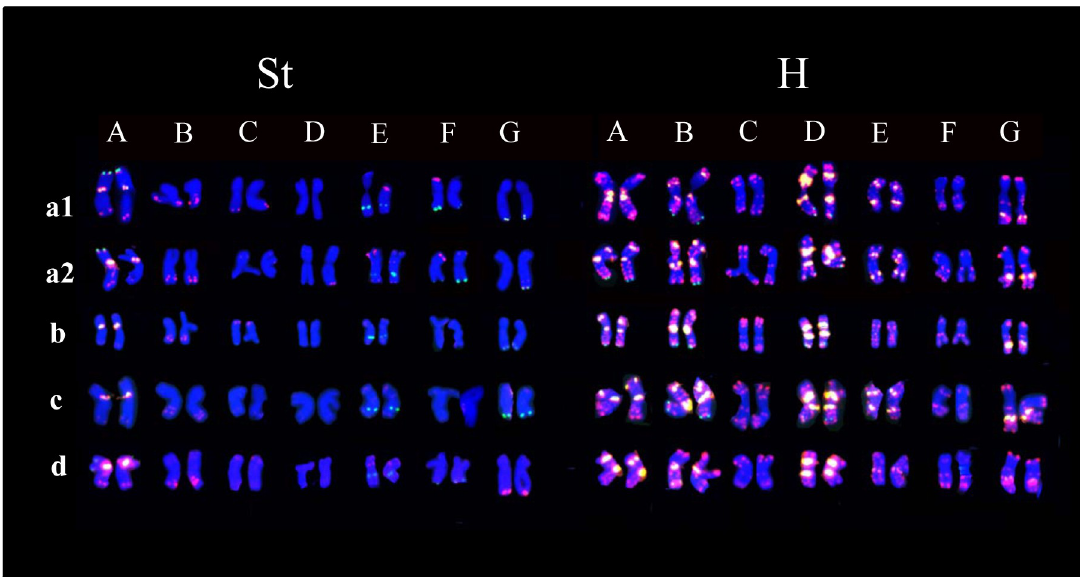
Fig 3. Karyotyping of four Elymus sibiricus cultivars, probed with Oligo-pSc119.2 (green), ( AAG ) 10 (yellow), and Oligo-pAs1 (red). A1 and A2: Two different samples from Tongde; B: Chuancao No. 2; C: Qingmu No. 1; and D: Nongmu.